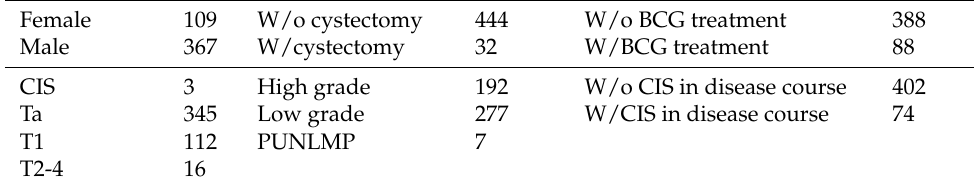
Table 1. Dataset characteristics. BCG—Bacillus Calmette–Guérin vaccine.